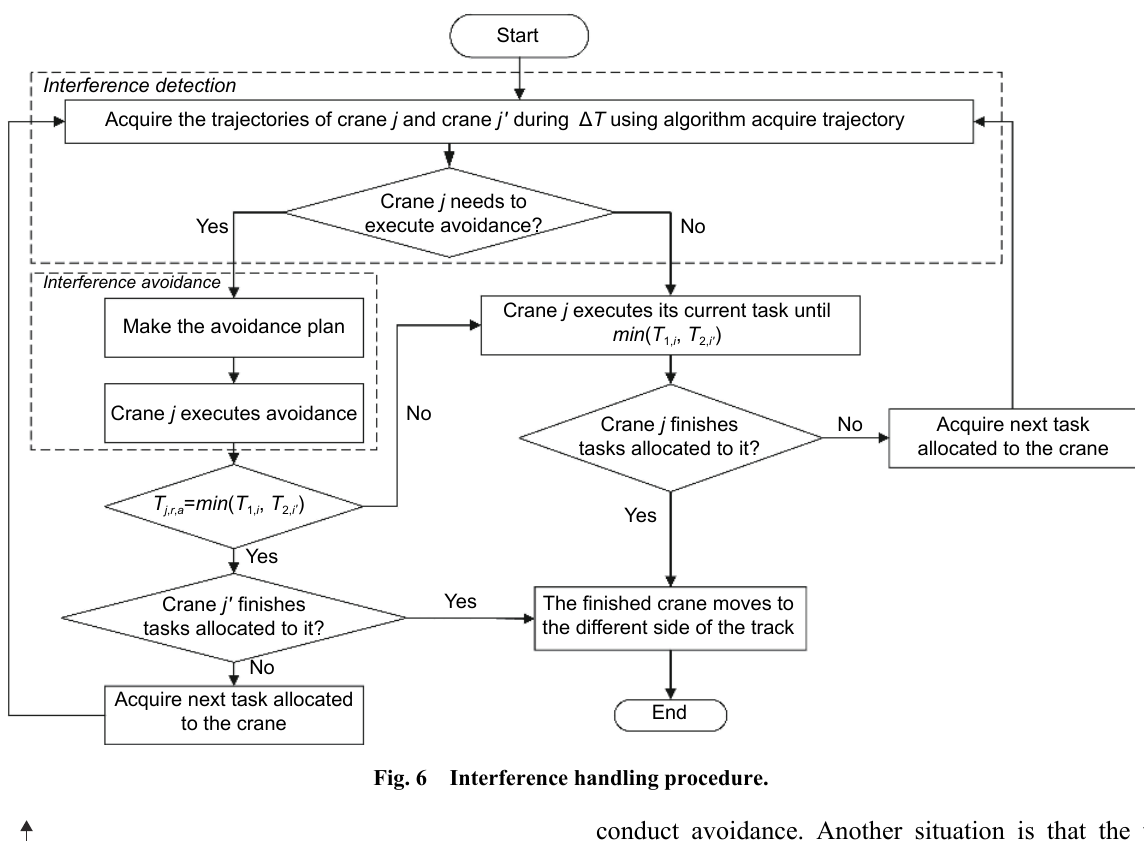
Fig. 6 Interference handling procedure.